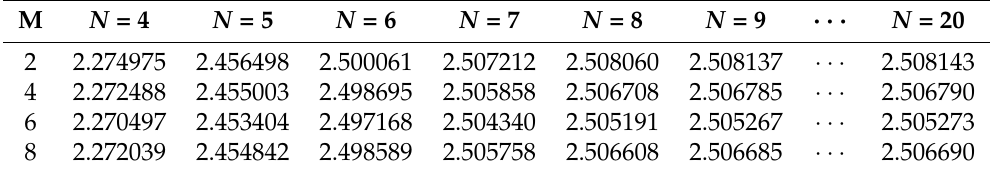
S n ( kR ) e in θ (cid:107) L 2 for R = 1 and k = 5, where S n is the numerical solution Table 1. The mean of (cid:107) ∑ N n = − N | c m | 2 ) 1/2 ≤ 0.1. The coefficients { c m } of q to the integral equation (5) with q ∈ X M such that ( ∑ M m = 1 are chosen randomly from the uniform distribution. The sample size is